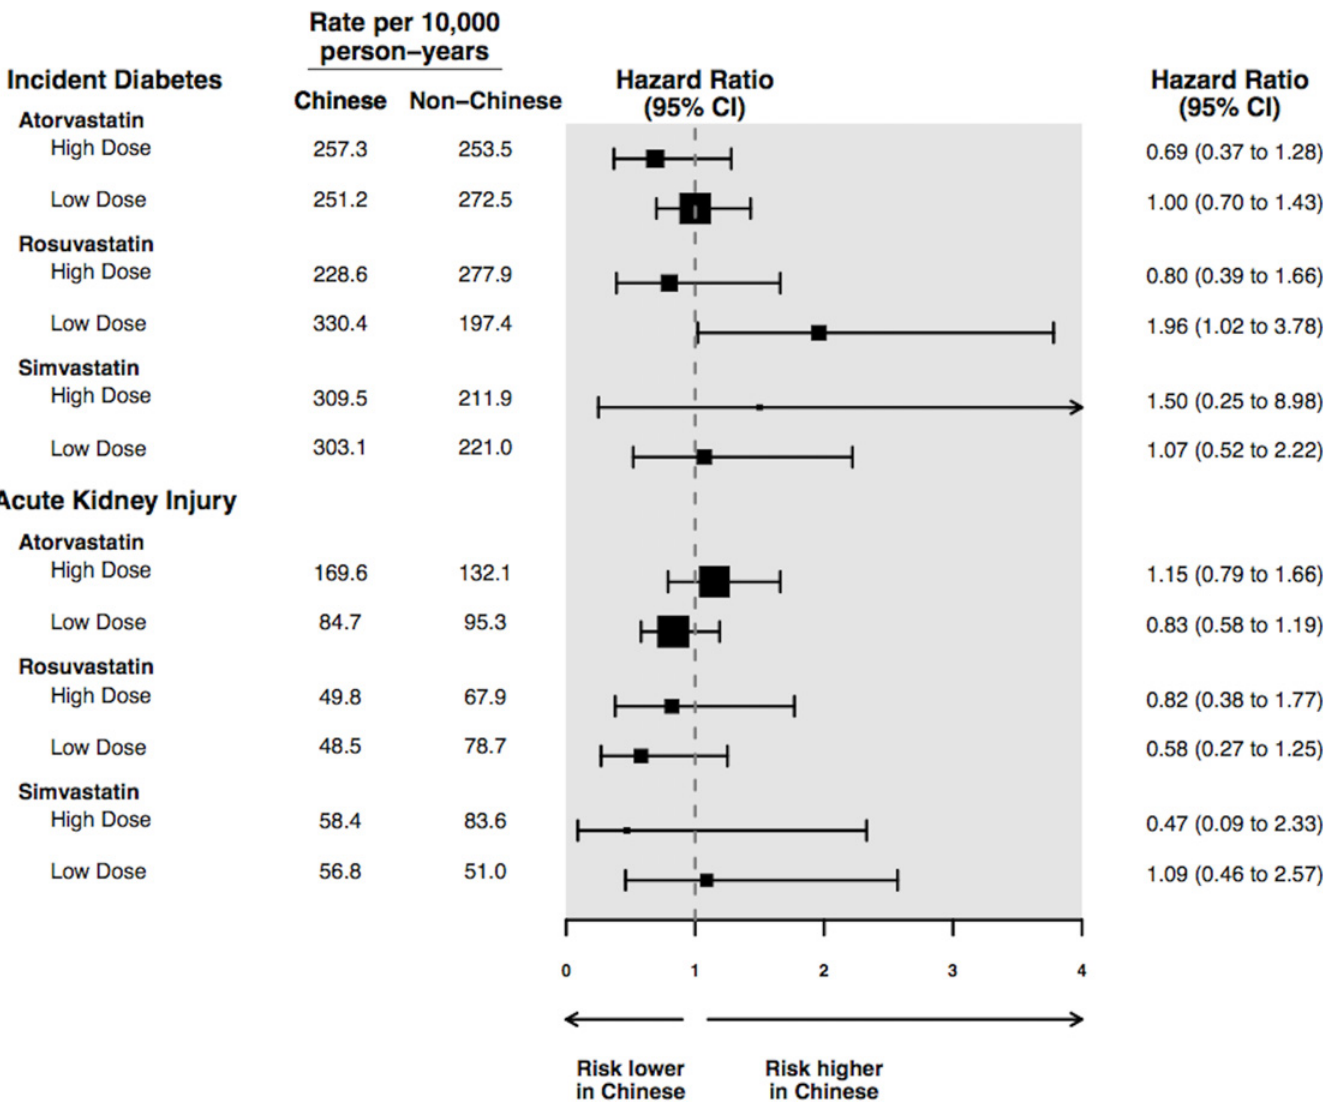
Fig 1. Subgroup analysis by statin type and dose for hospitalization with acute kidney. injury and a diagnosis of diabetes mellitus * † . * High dose defined as (cid:1) 10 mg rosuvastatin, (cid:1) 20 mg atorvastatin, or (cid:1) 40 mg simvastatin; other values classified as low dose. † To comply with privacy regulations numerators of 1 to 5 cannot be reported individually; for this reason we simply present the rate per 10,000 person-years, without additional information on the number of events in each